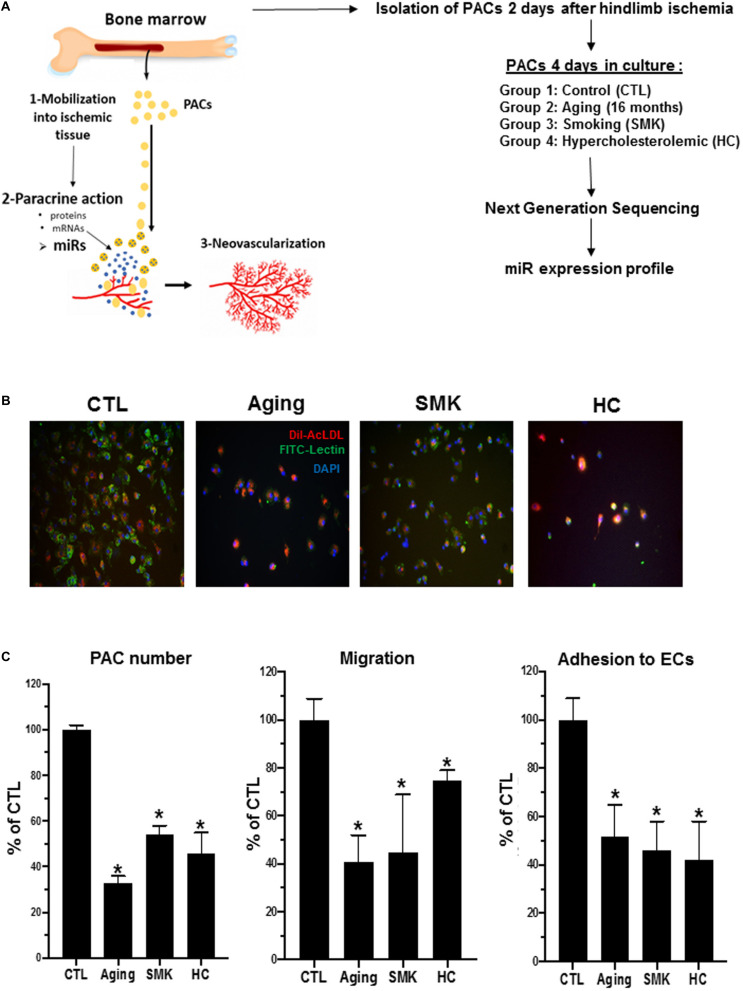
Experimental design and effect of aging, smoking (SMK), and hypercholesterolemia (HC) on the number and functional activities of PACs. (A) Schematic representation of PAC angiogenic function (left) and experiment design used for miR profiling in PACs (right). (B) Representative pictures of PACs isolated from control (CTL), aging, SMK, and HC mice at day 2 after hindlimb ischemia. PACs were cultured ex vivo for 4 days before staining with DAPI (blue), BS-1 lectin-FITC (green), and DiI-acLDL (red). (C) Quantitative analysis of PAC number, PAC migration capacity, and PAC adhesion to endothelial cells (ECs) in the different groups of mice. Data are mean ± SEM (n = 4–6/group). *P < 0.05 versus CTL.